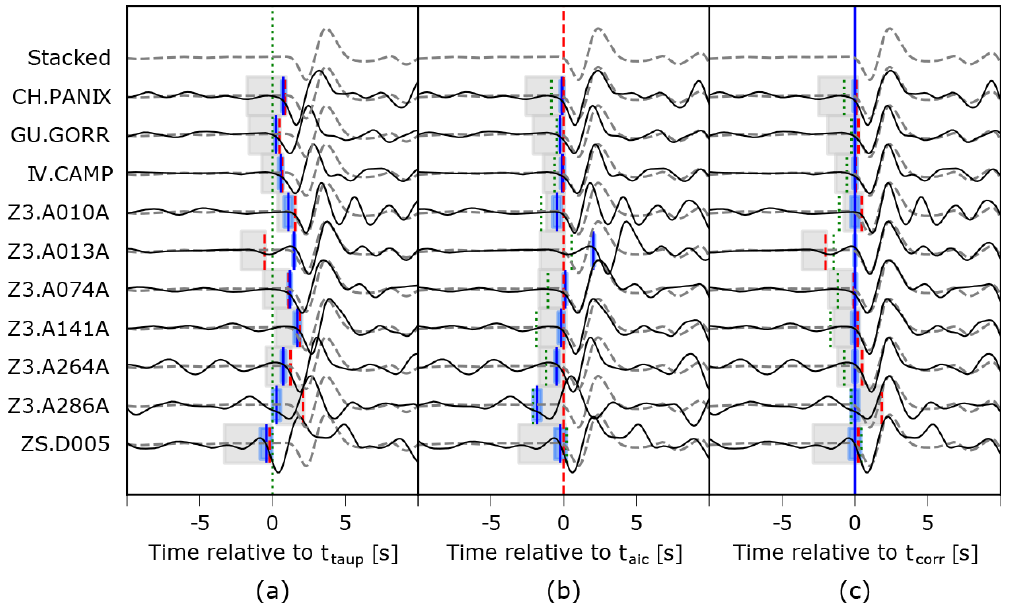
Figure 5. Waveform fit for P arrivals of a M 5 . 6 event on 7 August 2018 using the beam waveform as reference (dashed line). (a) Traces of different exemplary stations aligned by their theoretical onset (green dotted line). Travel-time residuals (not demeaned) for each trace can be read from the differences of AIC (red dashed line) and correlation onsets (blue solid line) to the theoretical onset. Onset uncertainties are displayed by shaded areas in grey (for absolute AIC onsets) and blue colours (for relative onsets based on cross-correlation), respectively. There is a good agreement between AIC and correlation-based onsets; however, the estimated absolute uncertainty of the AIC onsets is large, often exceeding the residual to the theoretical onset. (b) Alignment of traces by their AIC onset. Overlap with the beam trace is good but fails in certain cases of higher noise, which can lead to AIC onsets that are too early (e.g. Z3.A013A) as well as too late (e.g. Z3.A286A). (c) Alignment by the correlation-corrected onsets. Overlap with the beam trace is close to ideal. The estimated uncertainty of correlation- corrected onsets is by a factor of about 10 lower than that of the AIC picks. Note the increased uncertainty for trace ZS.D005 and Z3.A010A exhibiting significant